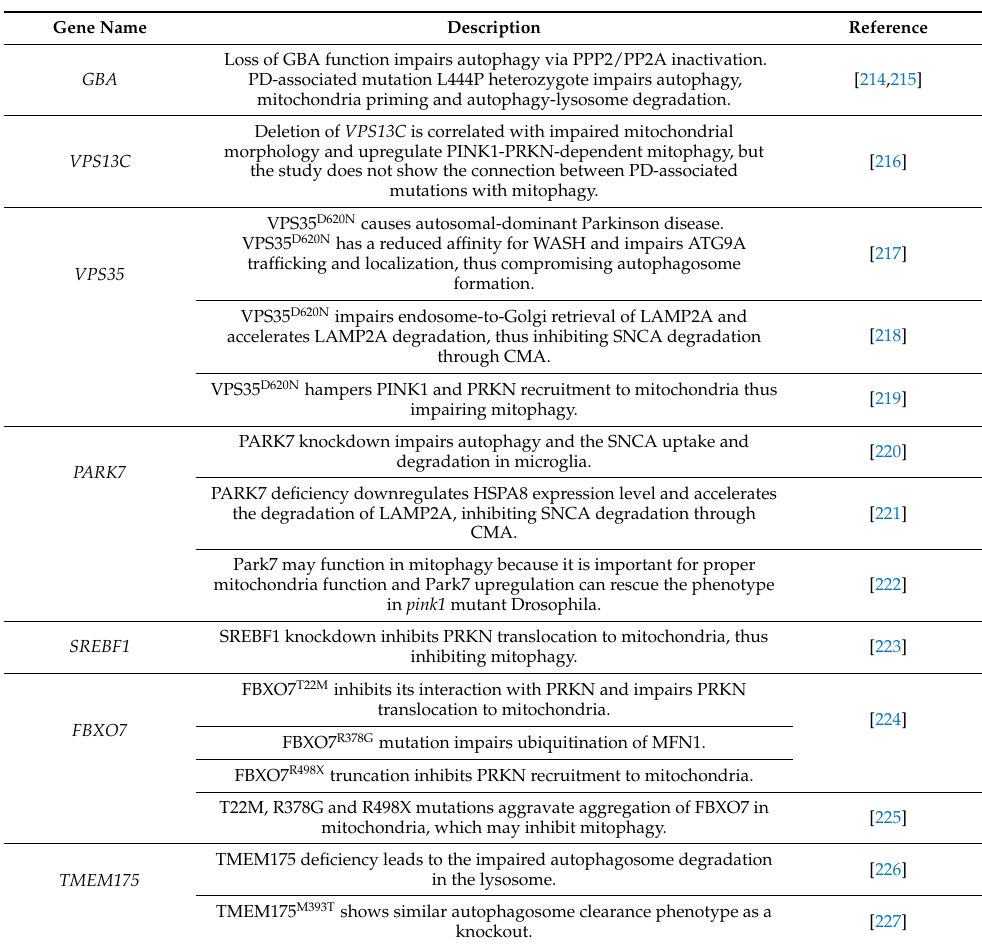
Table 1. PD-associated genes from GWAS and their connection with autophagy (except SNCA , LRKK2 , PINK1 and PRKN